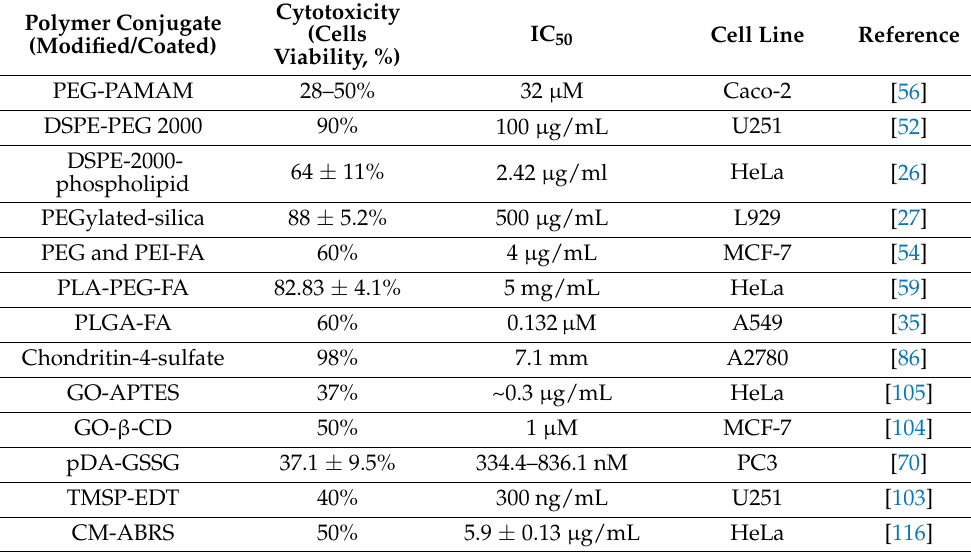
Table 4 summarizes the nano-conjugates’ cell viability assays against a number of different cell lines. The lowest cell viability was observed for the PEG-PAMAM, graphene oxide (GO), GO-APTES conjugates against Caco-2 and HeLa cell lines. Among the nano- conjugates active against the breast cancer cell lines MCF-7, the GO- β -CD conjugate with 50% cell viability, and a 1 µ M, IC 50 value were observed. Table 4. Different parameters of the SPIONs–polymer conjugates for the delivery of DOX. Polymer Conjugate